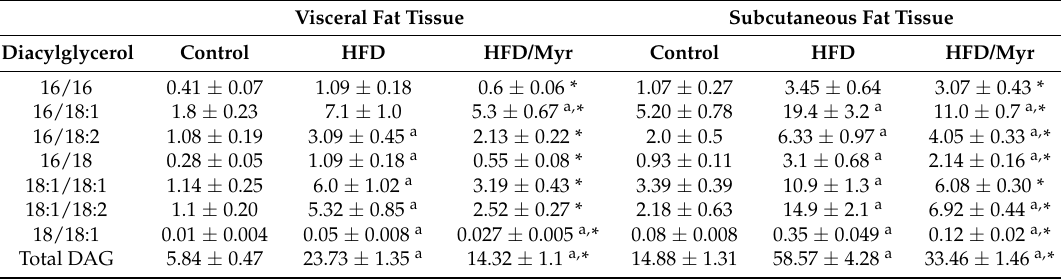
Table 4. DAG in two depots of adipose tissue. Values are mean (pmol/mg tissue) +/ − SD. Visceral Fat Tissue Subcutaneous Fat